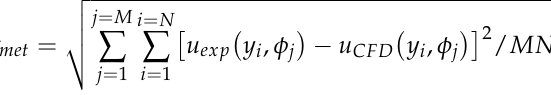
Figure 15. Comparison between velocity profiles from the experiment and the transition-SST model for drive ratio of ( a ) 0.65% and ( b ) 0.45%. Location 10 mm from the joint inside the cold channel.